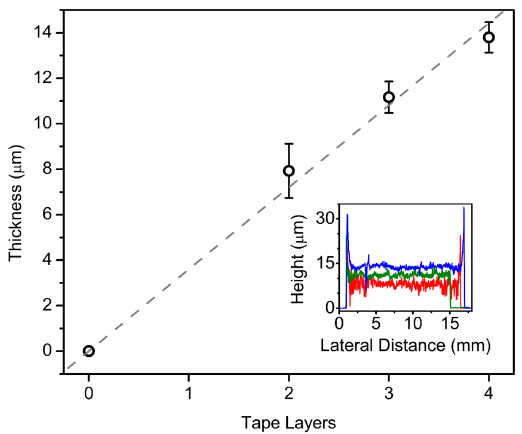
Figure 3. Stylus profilometry measurements of meso-macroporous antimony-doped tin oxide (ATO) coatings with tape layers of 1 × (black), 2 × (red), 3 × (green) and 4 ×